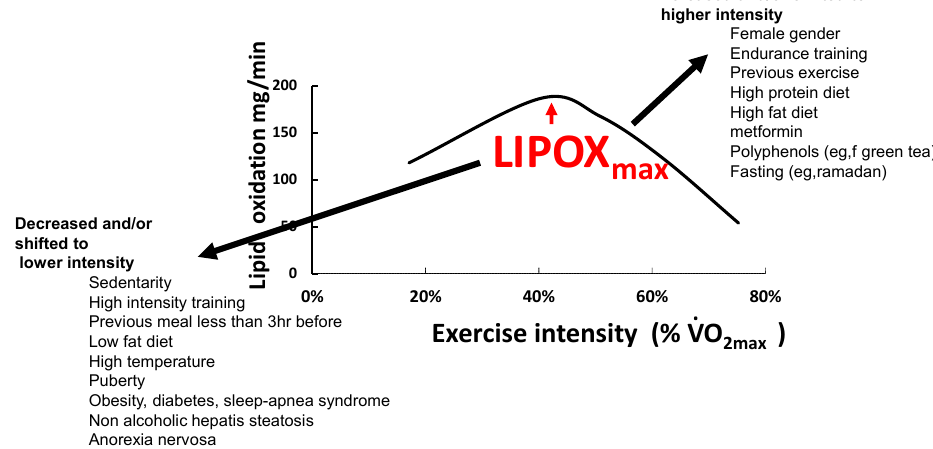
Figure 5. Schematic representation of physiological situations that modify the asymmetrical dome- shaped curve of lipid oxidation.